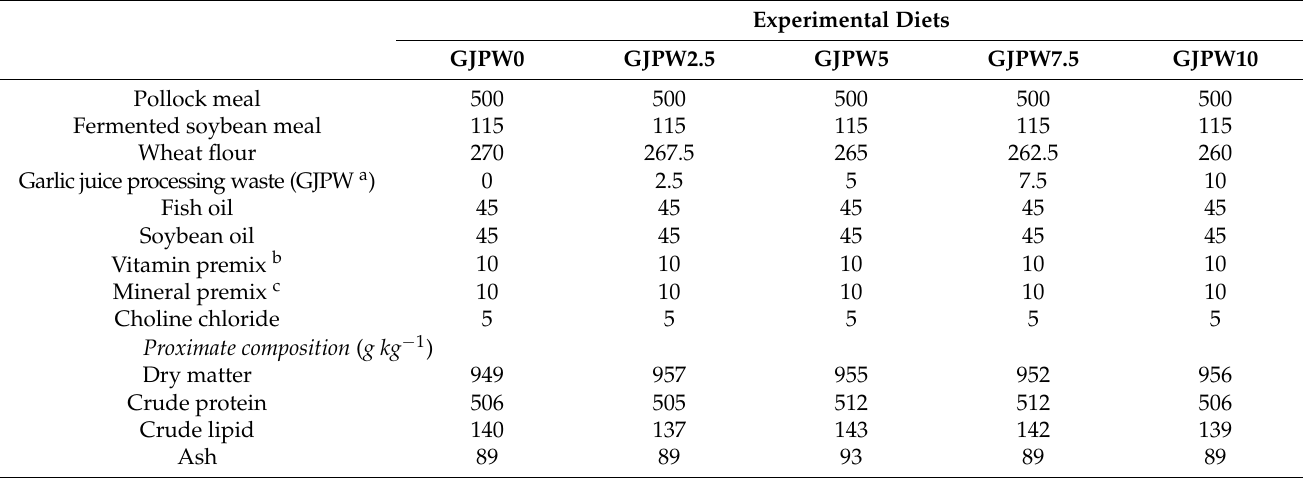
Table 2. Experimental diet formulation (g kg − 1 , dry matter